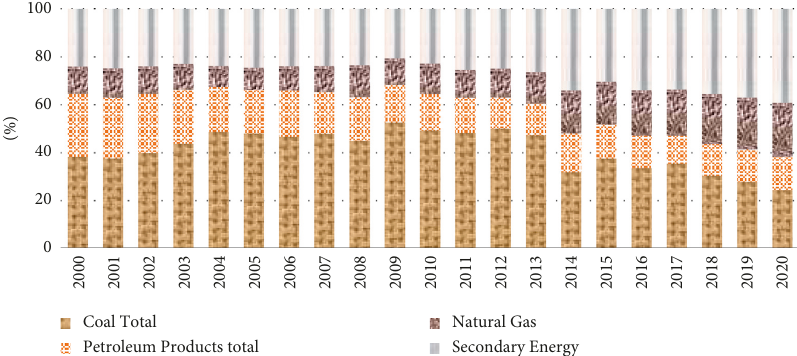
Figure 4: Comparative analysis of energy consumption structure of mining industry from 2000 to